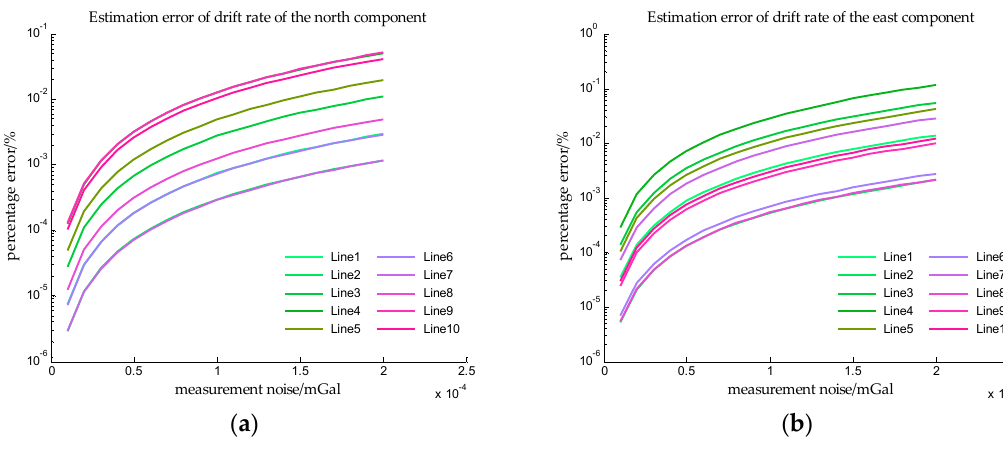
Figure 20. The estimation error of drift rate on the short survey lines in simulation VI. ( a ) is the estimation error of the drift rate of the north component, and ( b ) is the estimation error of the drift rate of the east component.